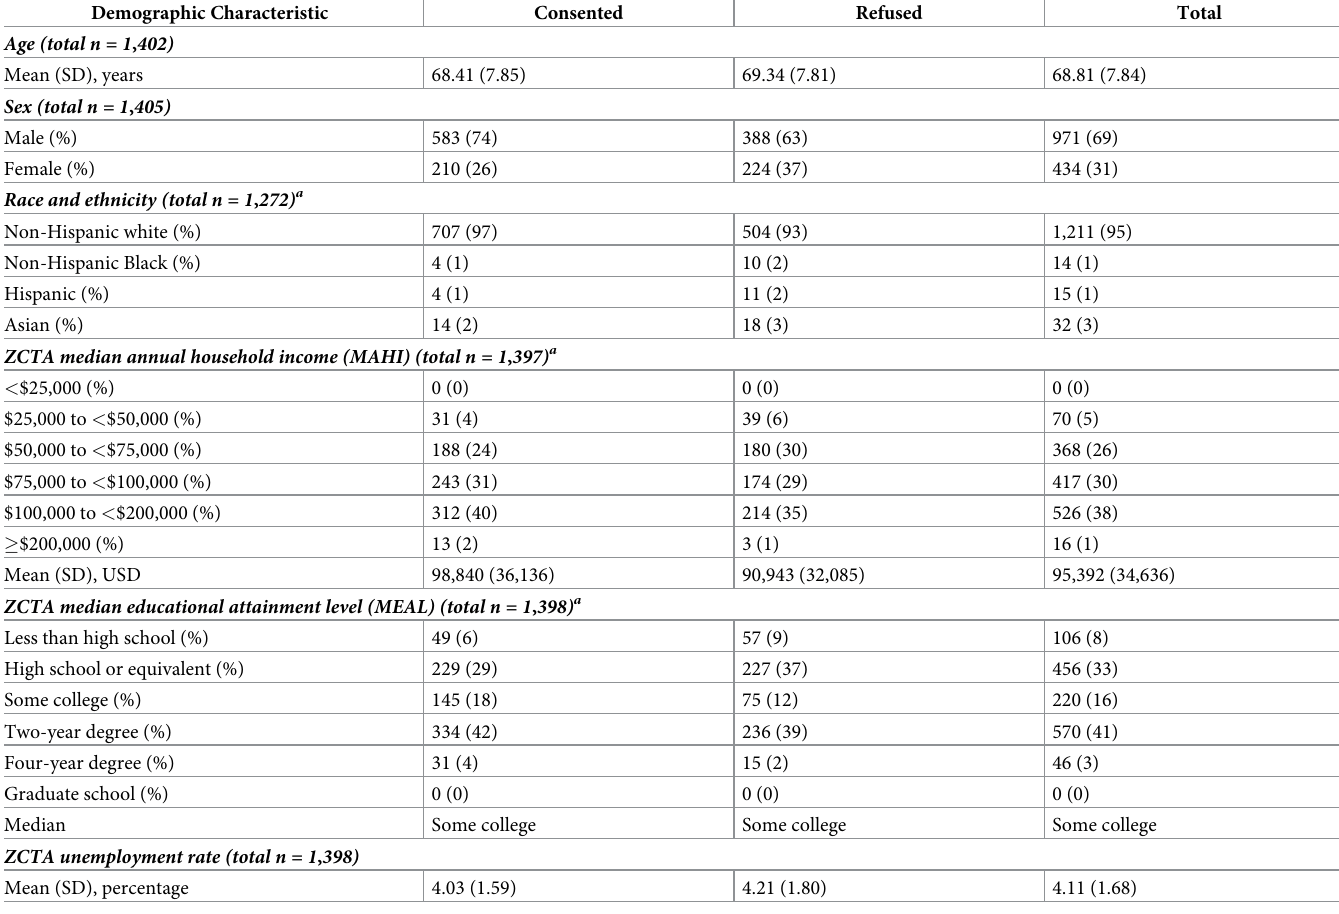
Table 1. Demographic characteristics of approached eligible patients for the NO/AKI and MINDDS